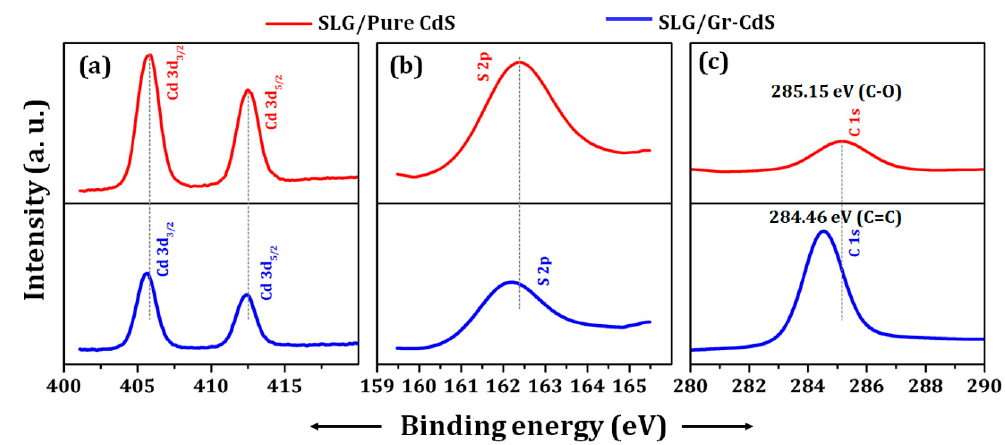
Figure 3. High-resolution XPS spectra of pure CdS NPs and Gr–CdS nanocomposite: (a) Cd 3d, (b) S 2p, and (c) C